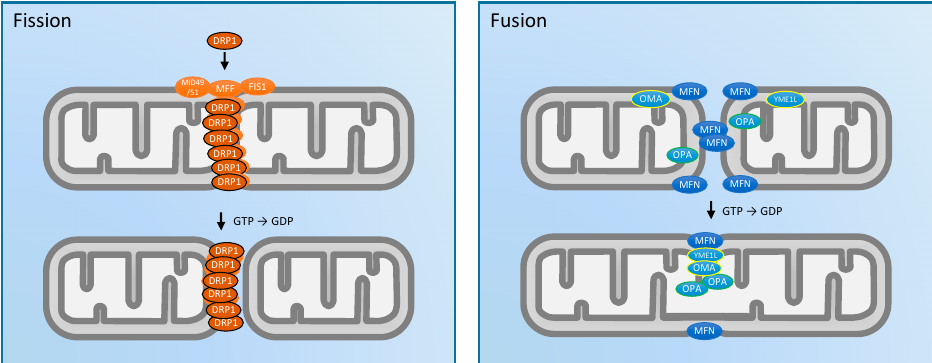
Figure 1. Overview of key proteins involved in mitochondrial fission and fusion. Fission processes depicted in orange: dynamin-related protein-1 (DRP1) can bind to a range of receptor proteins mitochondrial fission factor (MFF), mitochondrial fission 1 protein (FIS1), and mitochondrial dynamics proteins of 49 and 51 kDa (MID49/51) on the outer mitochondrial membrane. Upon guanosine triphosphate (GTP) hydrolysis, DRP1 oligomers constrict to divide mitochondria into separate organelles. Fusion processes depicted in blue: GTPase mitofusin (MFN1/2) of separate mitochondria dimerize, and then pull together upon GTP hydrolysis to fuse the outer mitochondrial membranes (OMM). The inner mitochondrial membrane (IMM) is fused by the binding of optic atrophy-1 (OPA1) which faces the intermembrane space (IMS) while tethered to the IMM of each incoming mitochondria. Regulation of IMM fusion occurs via proteases metalloendopeptidase mitochondrial (OMA) and ATP-dependent zinc metalloprotease 1 (YME1L) which cleave the membrane tethered domain of OPA1 from the IMM, rendering it non-functional. GDP: guanosine